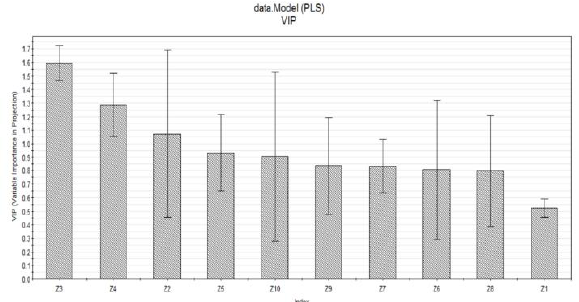
Figure 11. Contribution of different